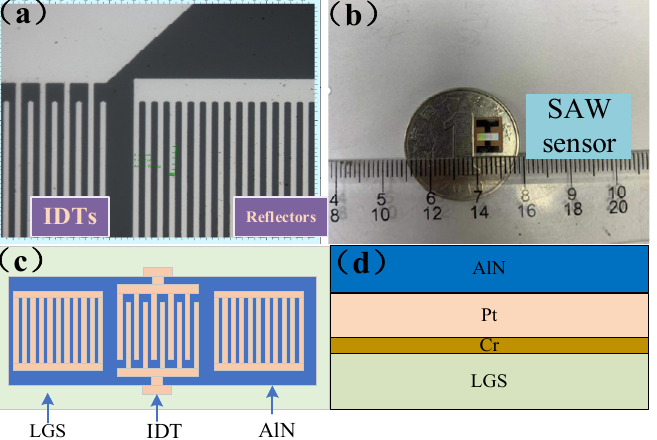
Figure 2. Structure design of surface acoustic wave (SAW) device: ( a ) the interdigital transducers (IDTs) structure; ( b ) SAW sensor; ( c ) diagram of sensor structure; ( d ) side view of the sensor structure.